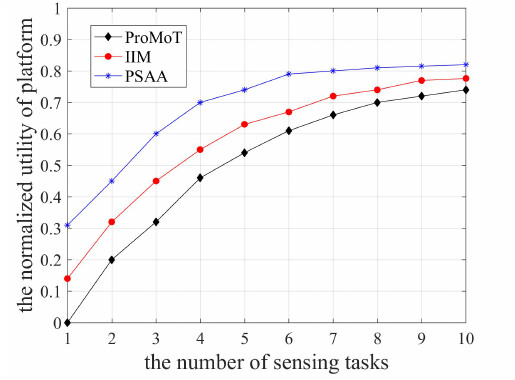
Figure 4. The utility of platform.